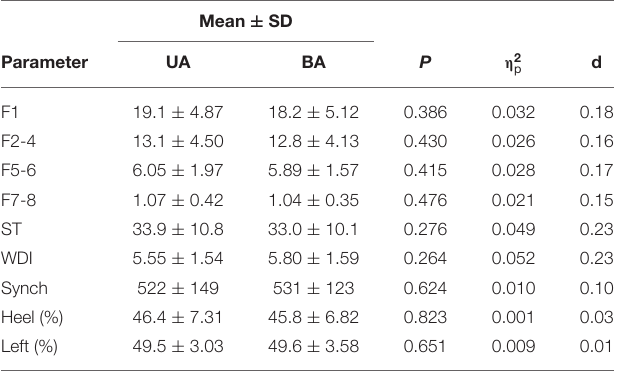
TABLE 3 | Interactive Balance System (IBS)—Descriptive comparison (mean ± SD, n = 25) and analysis of variance for setting Bonebridge/Vibrant-Soundbridge best aided and unaided based on all positions (mean values).